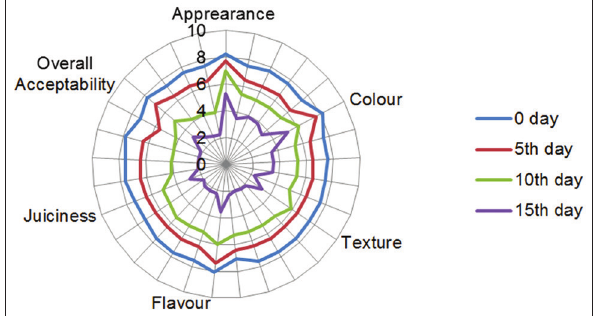
Figure-1: Effect of CS and LS on sensory qualities of pork sausage at different storage periods CS=Conventional smoking, LS=Liquid